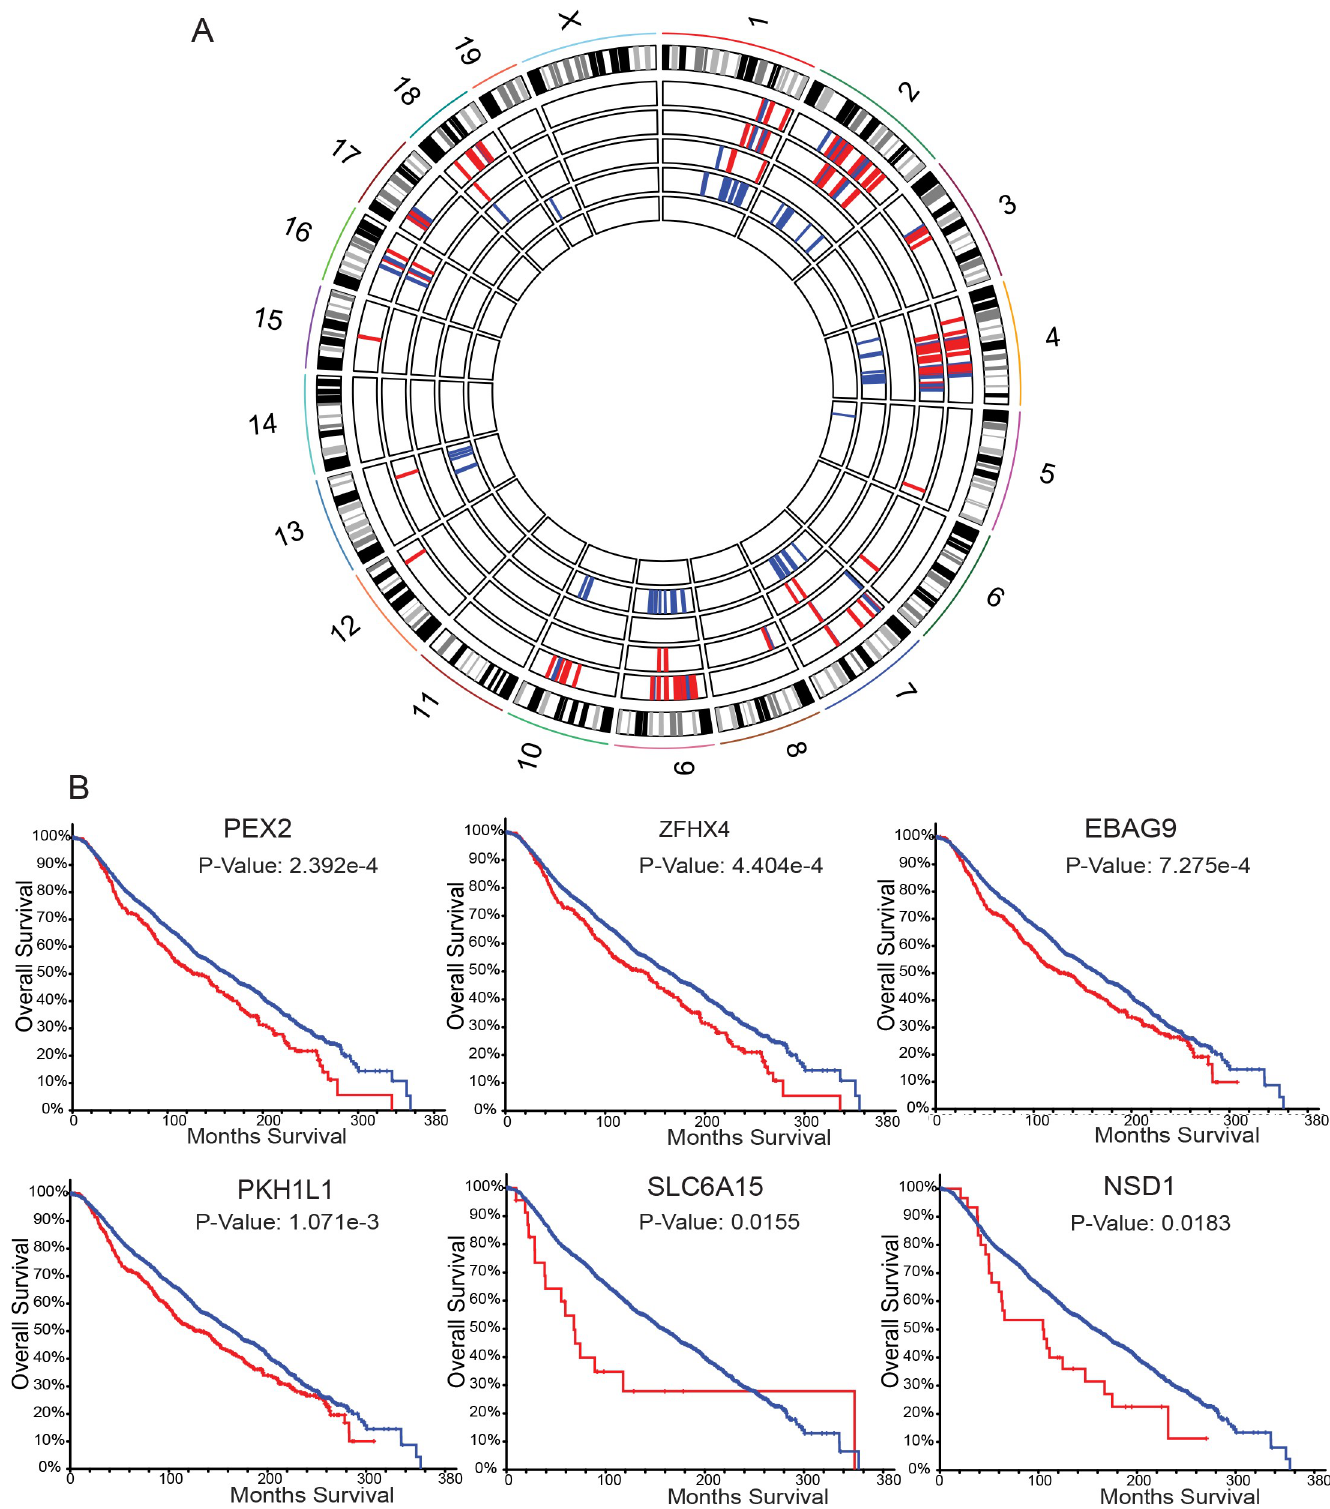
Fig 4. Metastasis-specific CNVs in the PyMT and Her2 mouse models. A. Circos plot representing metastasis-specific genomic alterations. The outermost track shows the mouse chromosomes and established G-banding. The remaining five inner tracks show deleted (and amplified for MOLF/EiJ only) genomic regions in F1 PyMT mice resulting in enrichment of the non-FVB/NJ allele (red) or enrichment of FVB/NJ allele (blue). From the outermost track the strain order is as follows: